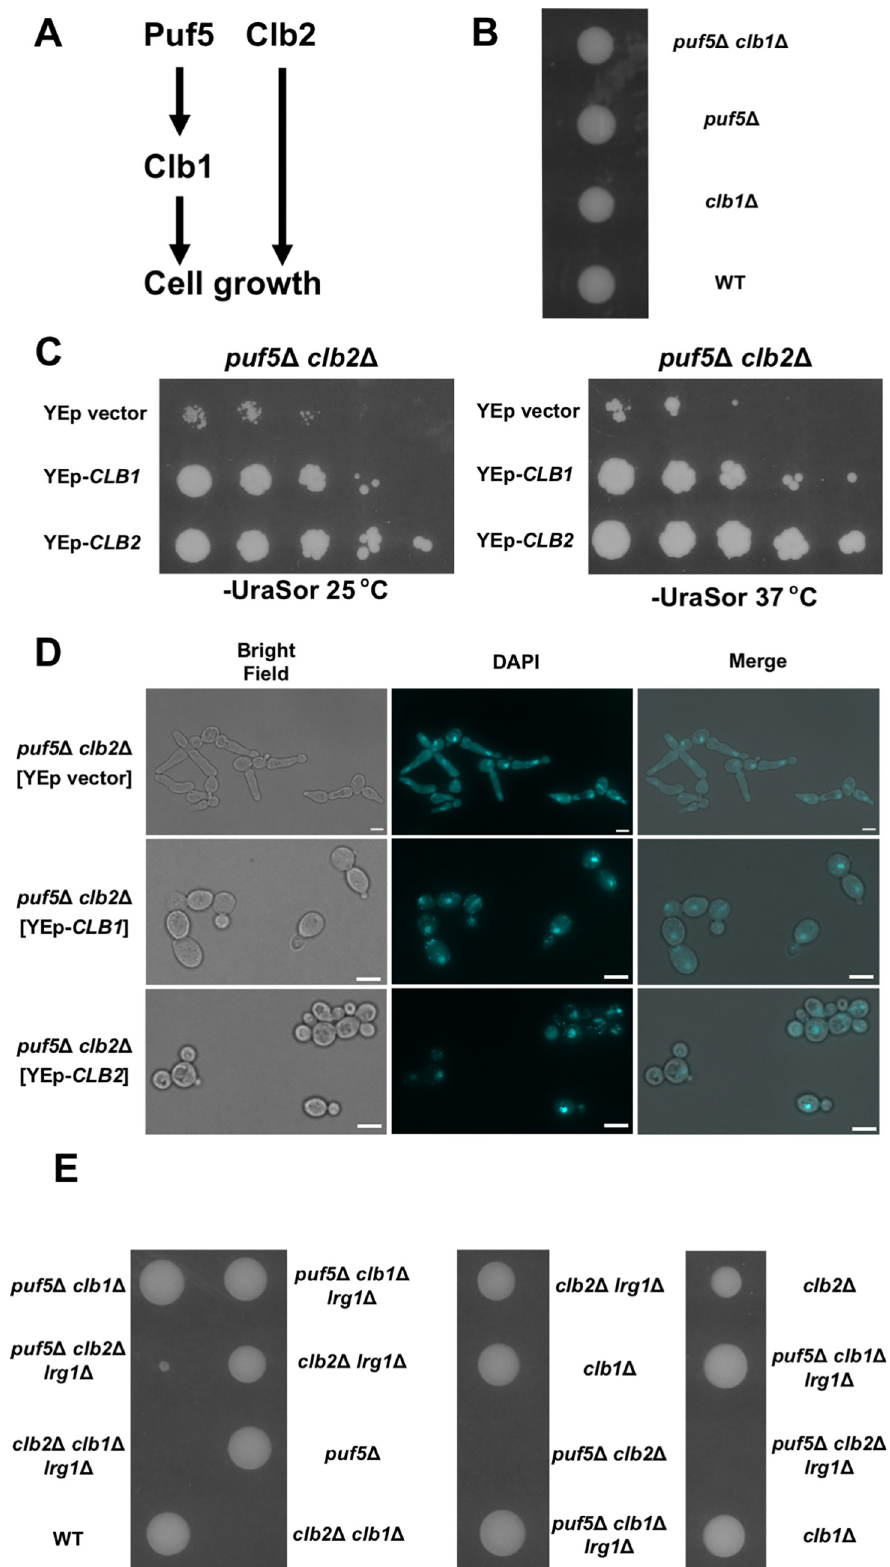
Fig 3. The decrease of CLB1 expression in the puf5 Δ mutant contributes to the growth defect of the puf5 Δ clb2 Δ double mutant. (A) A model of the Puf5 function in cell growth showing the hypothesis that Puf5 controls cell growth through the positive regulation of CLB1 , a paralog of CLB2 . (B) The tetrad analysis of the strains that are